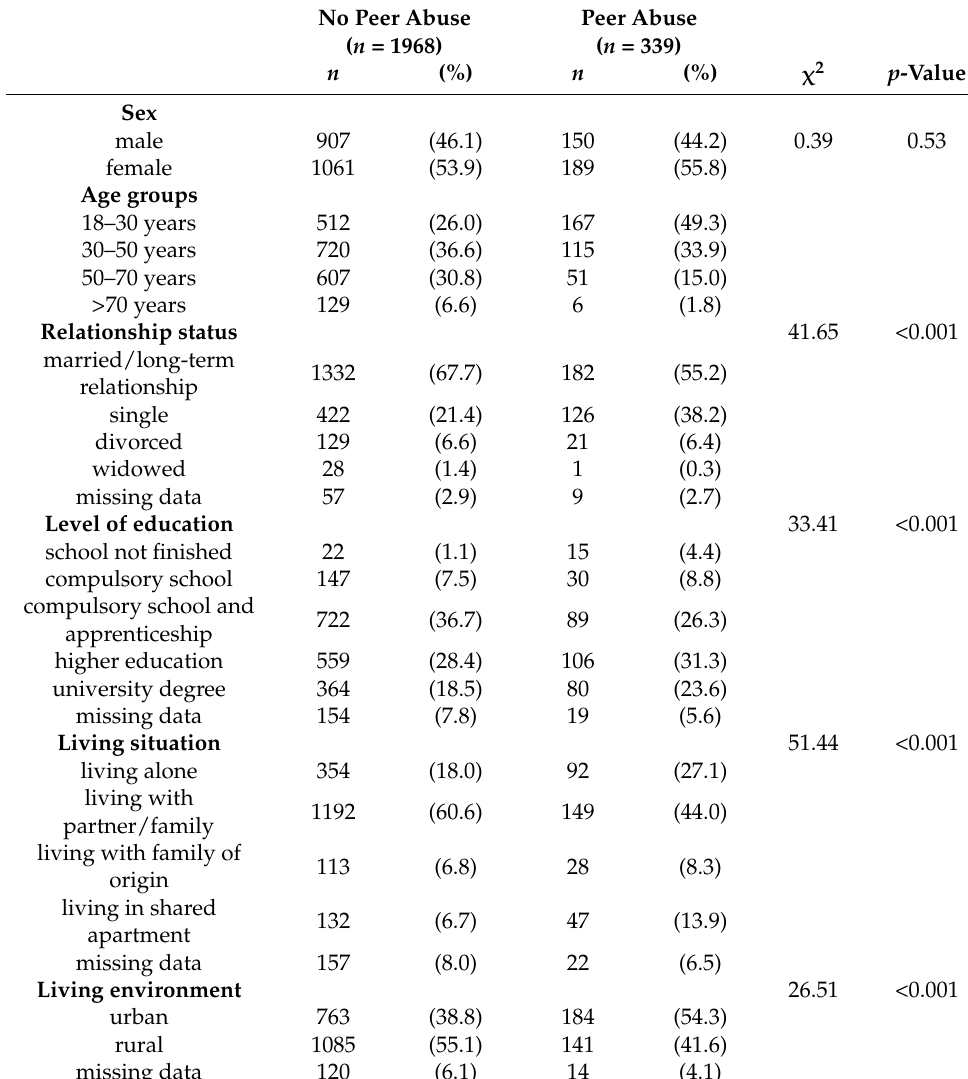
Table 1. Sociodemographic characteristics ( n =